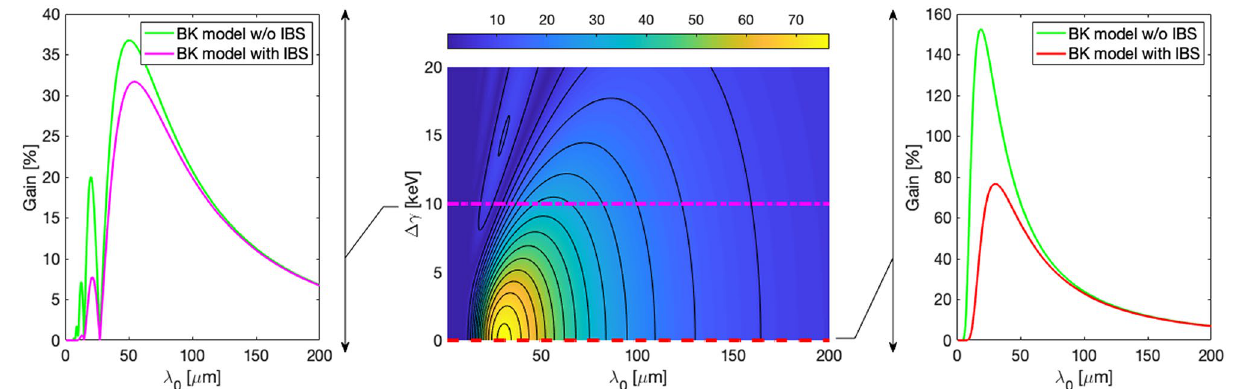
Figure 2. Center: Gain map obtained with BK formalism at the end of FERMI linac, as a function of modulation uncompressed wavelength and laser heater induced energy modulation. On the right, spectral gain profile with no LH. On the left, gain profile for a LH-induced energy modulation of 10 keV. Both profiles are also shown without IBS.